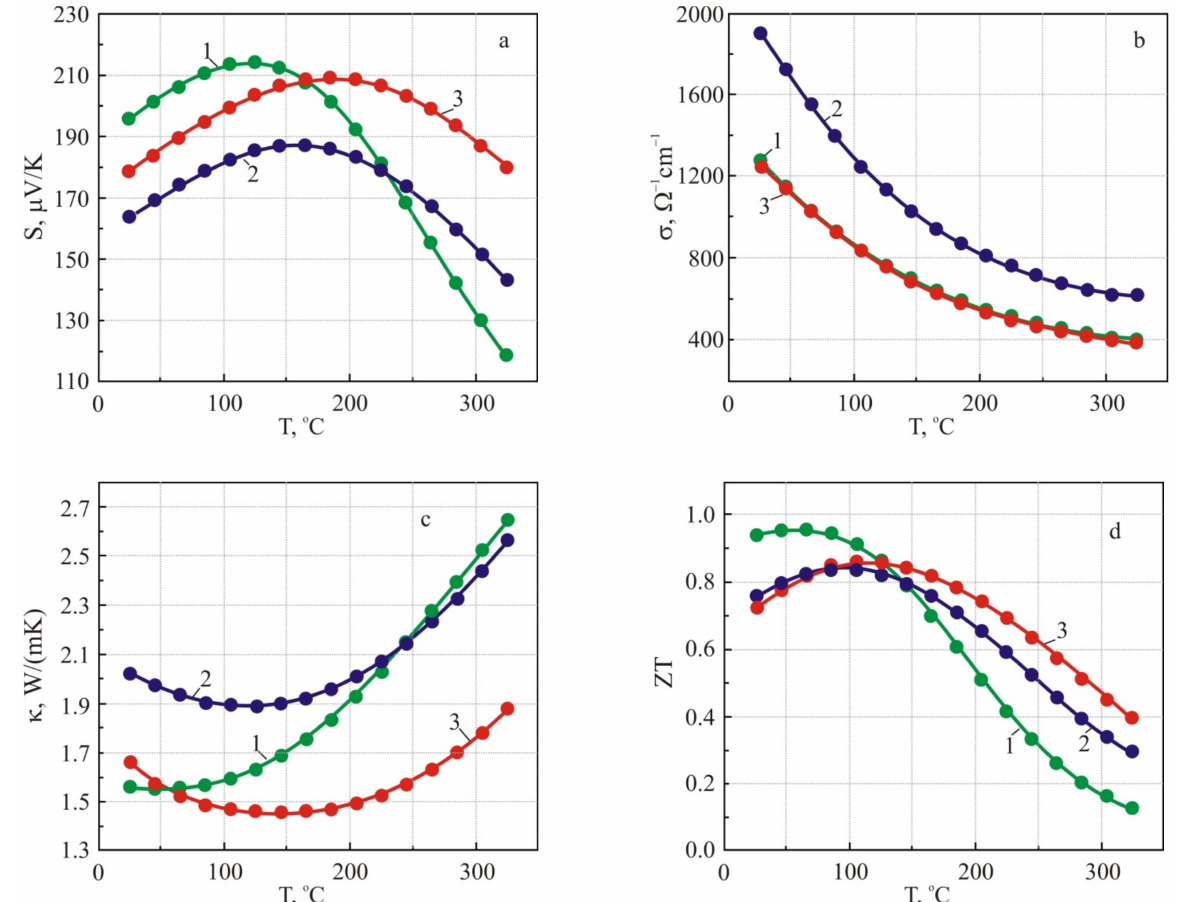
Figure 9. The temperature dependence of Seebeck coefficient ( a ), electrical conductivity ( b ), thermal conductivity ( c ), and the dimensionless figure of merit ZT ( d ) over 30—300 ◦ C temperature range for p -Type Bi 0.5 Sb 1.5 Te 3 fabricated by hot extrusion. 1—stoichiometric Bi 0.5 Sb 1.5 Te 3 (conventional orientation). 2—Bi 0.5 Sb 1.5 Te 3 + 0.5 wt.% Pb (conventional orientation). 3—Bi 0.5 Sb 1.5 Te 3 + 0.5 wt.% Pb (parallel to C